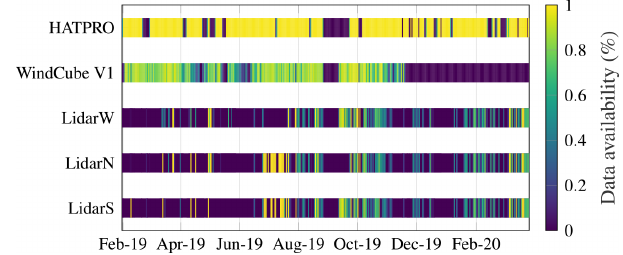
Figure 11. Daily data availability of every sensor deployed at Obrestad Lighthouse from February 2019 to April 2020. Data are shown as available for LidarS, LidarN and LidarW when the scanning beams were aligned with the wind direction recorded 100ma.s.l.